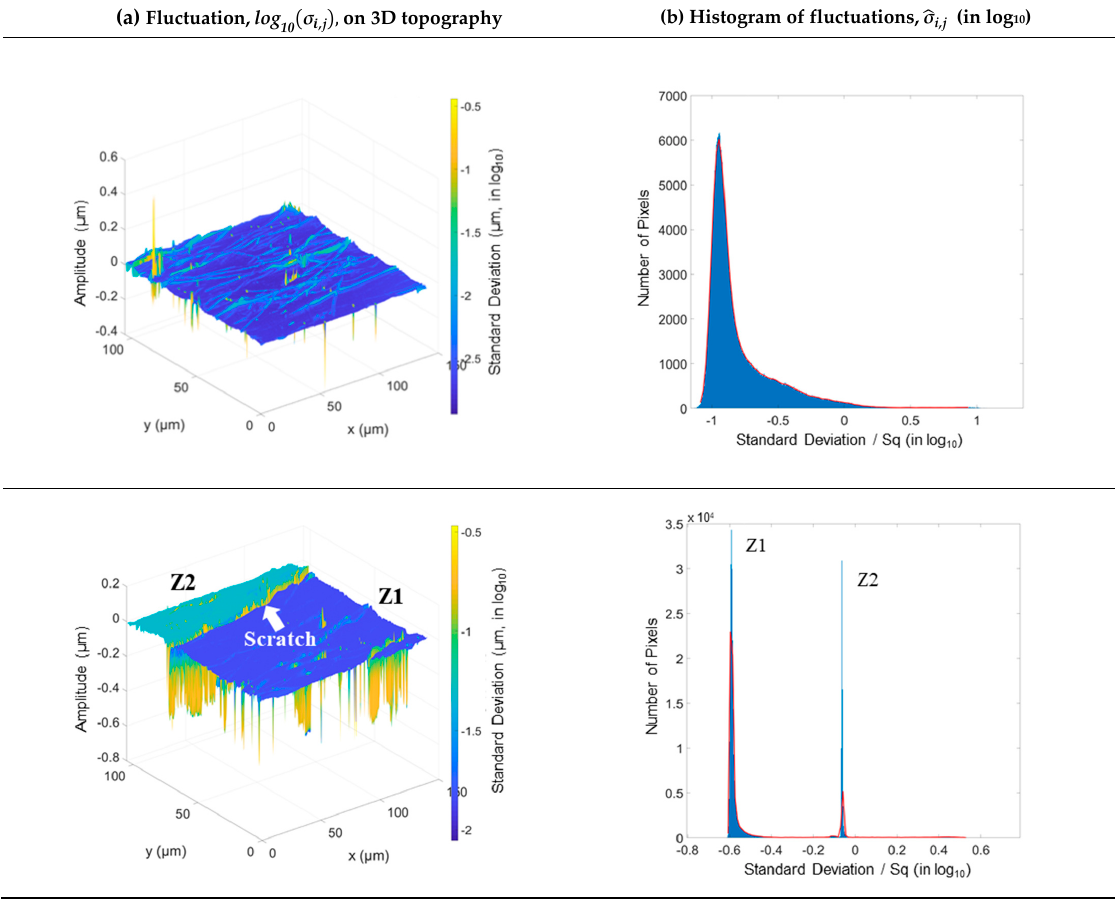
Figure 8. Fluctuations projected on the 3D topographies of the two measured locations of the ophthalmic lens ( a ) and the histogram of the normalized fluctuations ( b ).